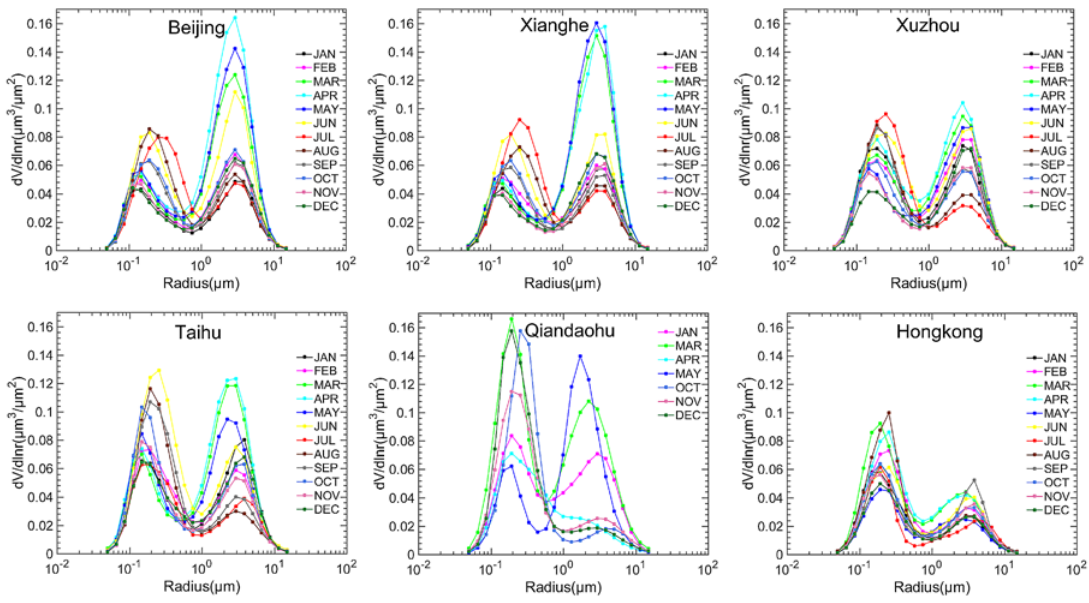
Figure 2. Monthly mean value of volume size distribution in AERONET sites of Beijing, Xianghe, Xuzhou, Taihu, Qiandaohu, and Hongkong, respectively.